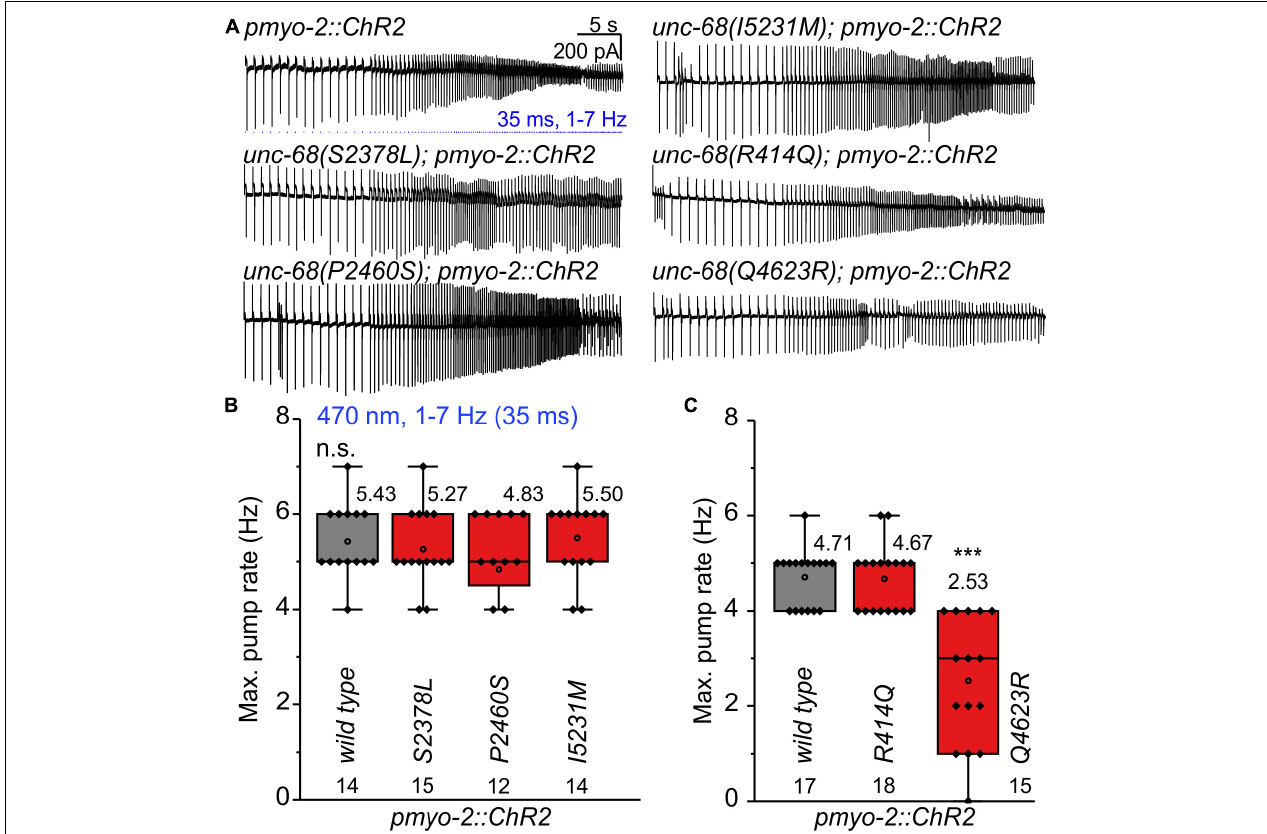
FIGURE 3 | Stress test (1–7 Hz) to determine the maximal pump rate of CPVT mutation-bearing strains. (A) Original recordings of electropharyngeograms (EPGs) obtained by electrophysiological characterization of cut-head preparations. Application of 1 Hz blue light pulses (1.5 mW/mm 2 , 35 ms) for 15 s followed by a stepwise increase (every 5 s) from 2 to 7 Hz. (B,C) unc-68(Q4623R) shows a reduced maximal pump rate in comparison to wt. Since pharyngeal pump ability sometimes varies among different experimental days, likely due to experimental conditions (room temperature, light-sensitivity of ATR), mutant alleles were always compared to the control animals recorded in the same batch of experiments. Box plots include every data point (rhomb), mean (open circle), and median (line). N-numbers, mean values, and significance levels (asterisks), referring to respective wt controls, are located either below or above the corresponding boxes. One-way ANOVA with the Bonferroni post-hoc test was performed: n.s., not significant, and *** P ≤